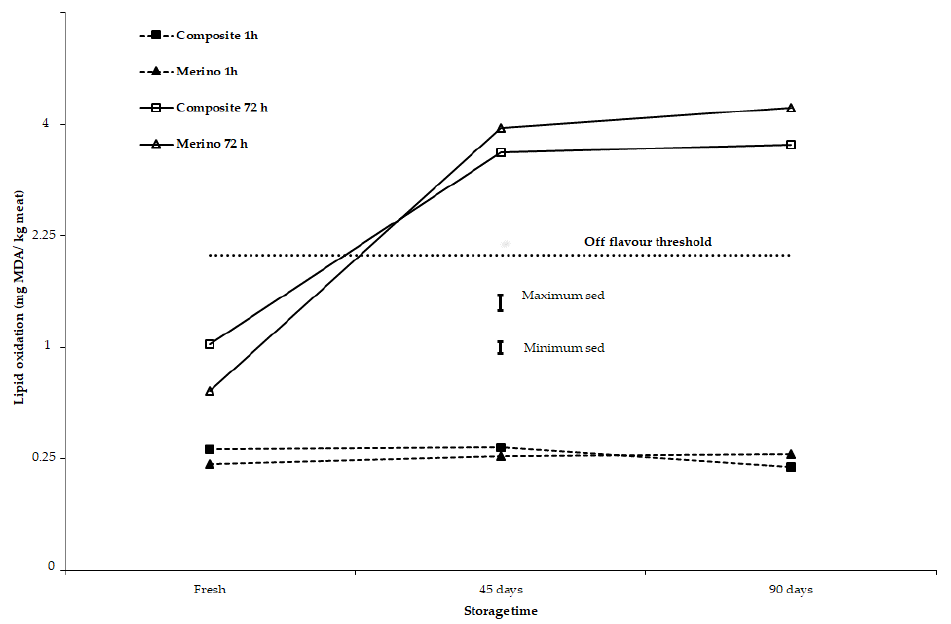
Figure 3. Effect of storage time (fresh, 45 and 90 days), retail colour display time (1 and 72 h) and animal type (lamb meat from Composite sheep and yearling meat from Merino sheep) on lipid oxidation (TBARS, mg MDA/kg meat). Results are presented on a square root scale along with the minimum and maximum standard errors of difference (sed) on that scale.